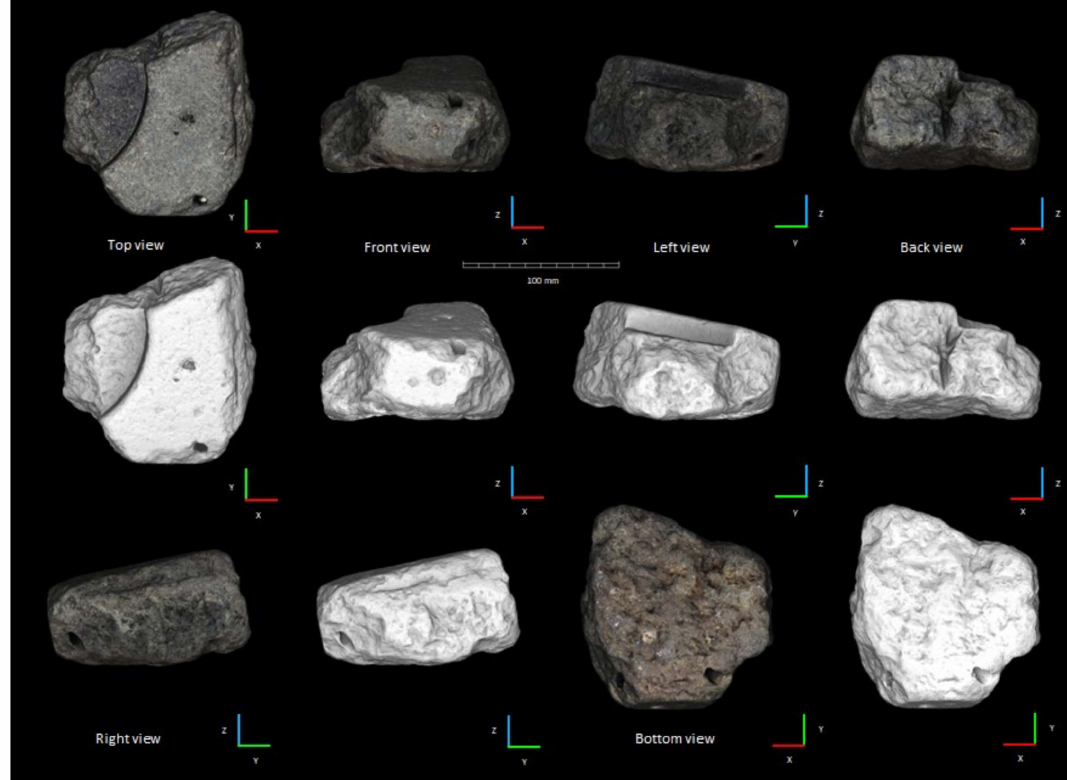
Figure 13. Orthoviews from B3 3D model, with texture and Shade Vis Plug-in; visualization with CloudCompare